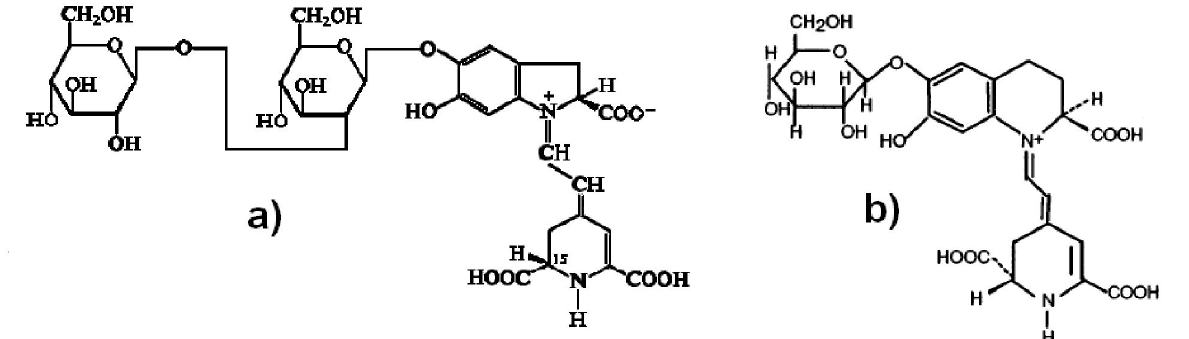
Figure 2. Chemical structures ( a ) bougainvillein-r-I (betanidin 5- O -β-sophorosides) and ( b )